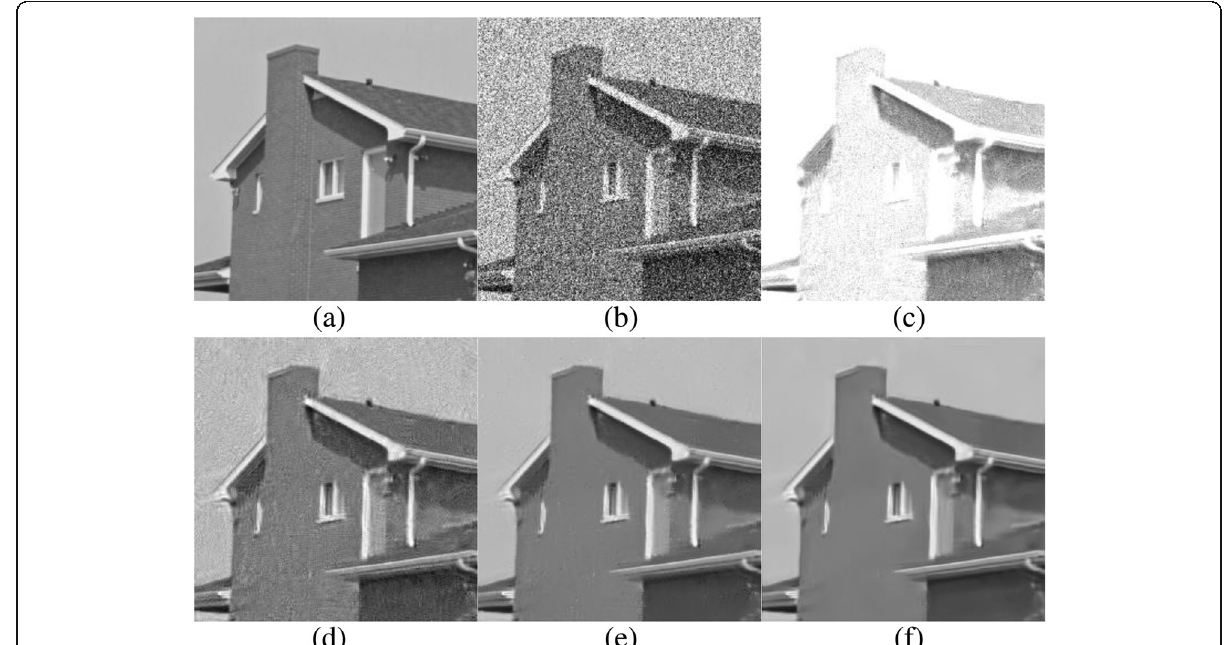
Fig. 5 Denoised results of House image at each step of SA-BM1-3D. a Original image, b noisy image ( σ =50), c step 1, d step 2, e step 3, and f step